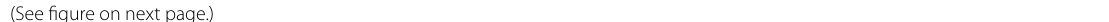
Weinheim)(See figure on next Fig. 5 a Schematic of the synthesis of nanofibrillated cellulose aligned hydrogel via the shear-induced biomimetic 4D printing method. Photographs of the actuation of complex flower morphologies oriented with long axis of each petal, and with time lapse during the swelling process. (a was reproduced with permission from Ref. [50], © 2016 Macmillan Publishers Limited). b Schematic of the synthesis of bilayer actuators using a sequential electrospinning method. The actuator comprises TPU (blue) and PNIPAAm (pink) using a UV cross-linking method. The materials were cut in different angles to obtain various orientations. c The actuation of the bilayer hydrogel depends on diverse orientations of the fibers in water at different temperatures. ( b , c were reproduced with permission from Ref. [51], © 2015, WILEY–VCH Verlag GmbH & Co. KGaA,